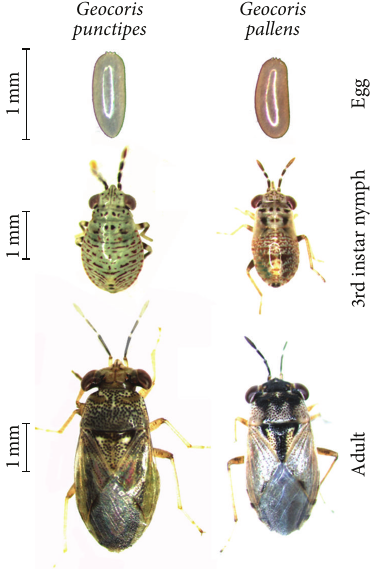
Figure 1: Comparison between Geocoris punctipes and G. pallens collected from the Great Basin Desert in southwestern